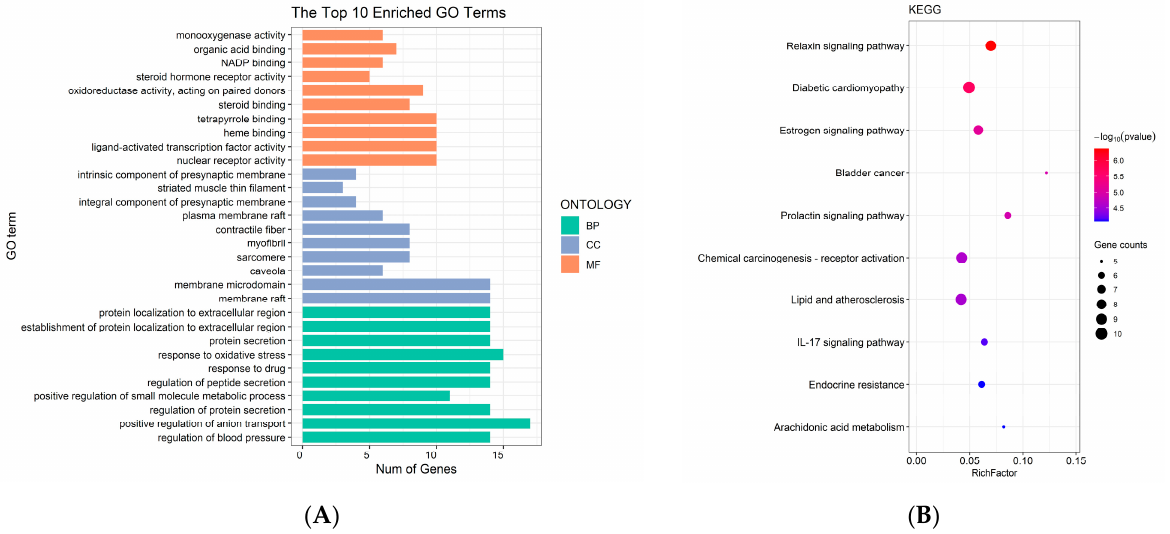
Figure 3. Intersecting targets of Oleum Cinnamomi with respect to the treatment of coronary heart disease for GO analysis ( A ) (BP: biological process; CC: cellular component; MF: molecular function); and KEGG enrichment analysis ( B ).